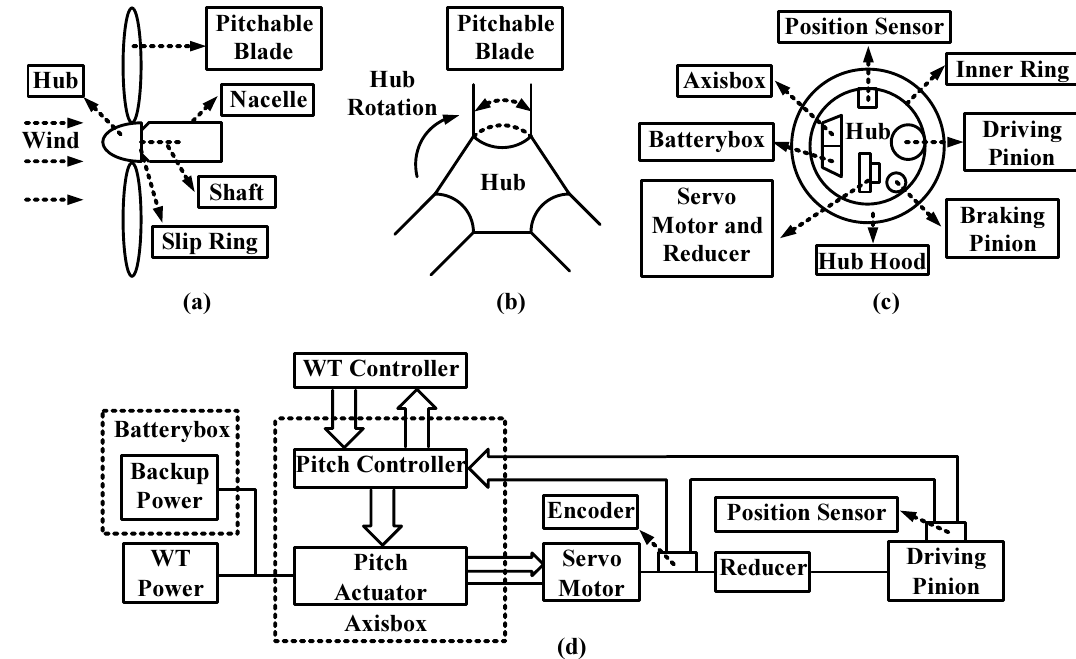
Figure 1. Physical structure of the variable-speed pitch system: ( a ) side view of the hub; ( b ) front view of the hub; ( c ) perspective view of the hub; ( d ) schematic diagram of a pitch system.